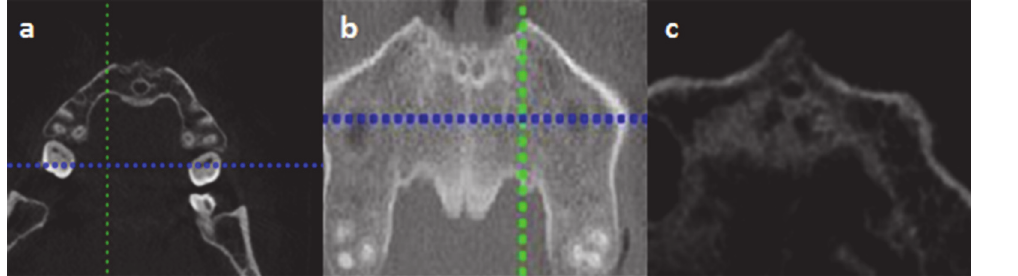
Fig 3. Representative images showing different number of channels seen at mid incisive